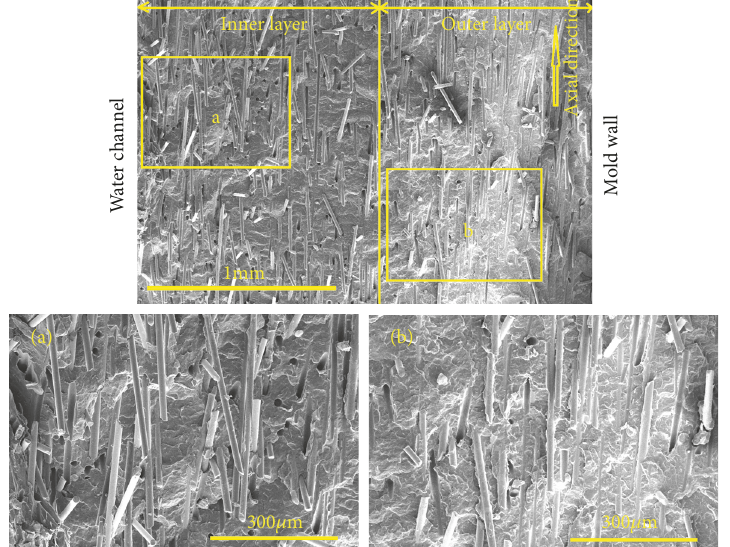
Figure 7: Representative SEM micrographs of RWT and Magnified views of (a) inner layer and (b) outer layer.